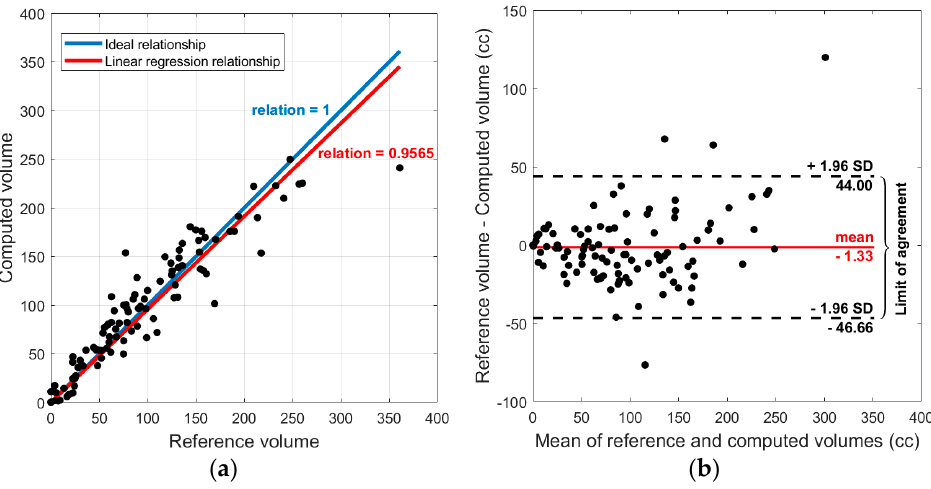
Figure 12. ( a ) Linear regression relation between the computed volume and reference volume. Each point corresponds to one patient. ( b ) Bland-Altman plot, which indicates the normality of error.